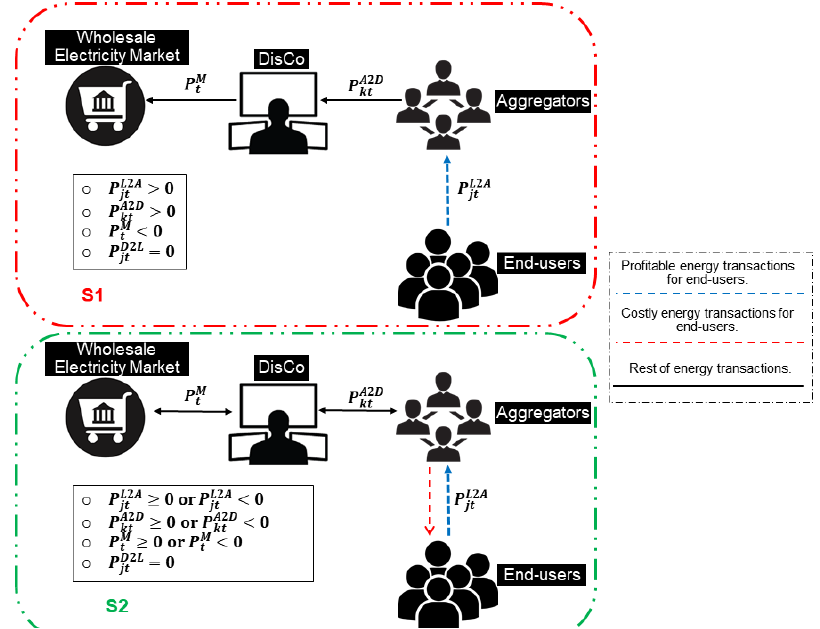
Figure 7. Energy trading flow between agents in the distribution network in Case